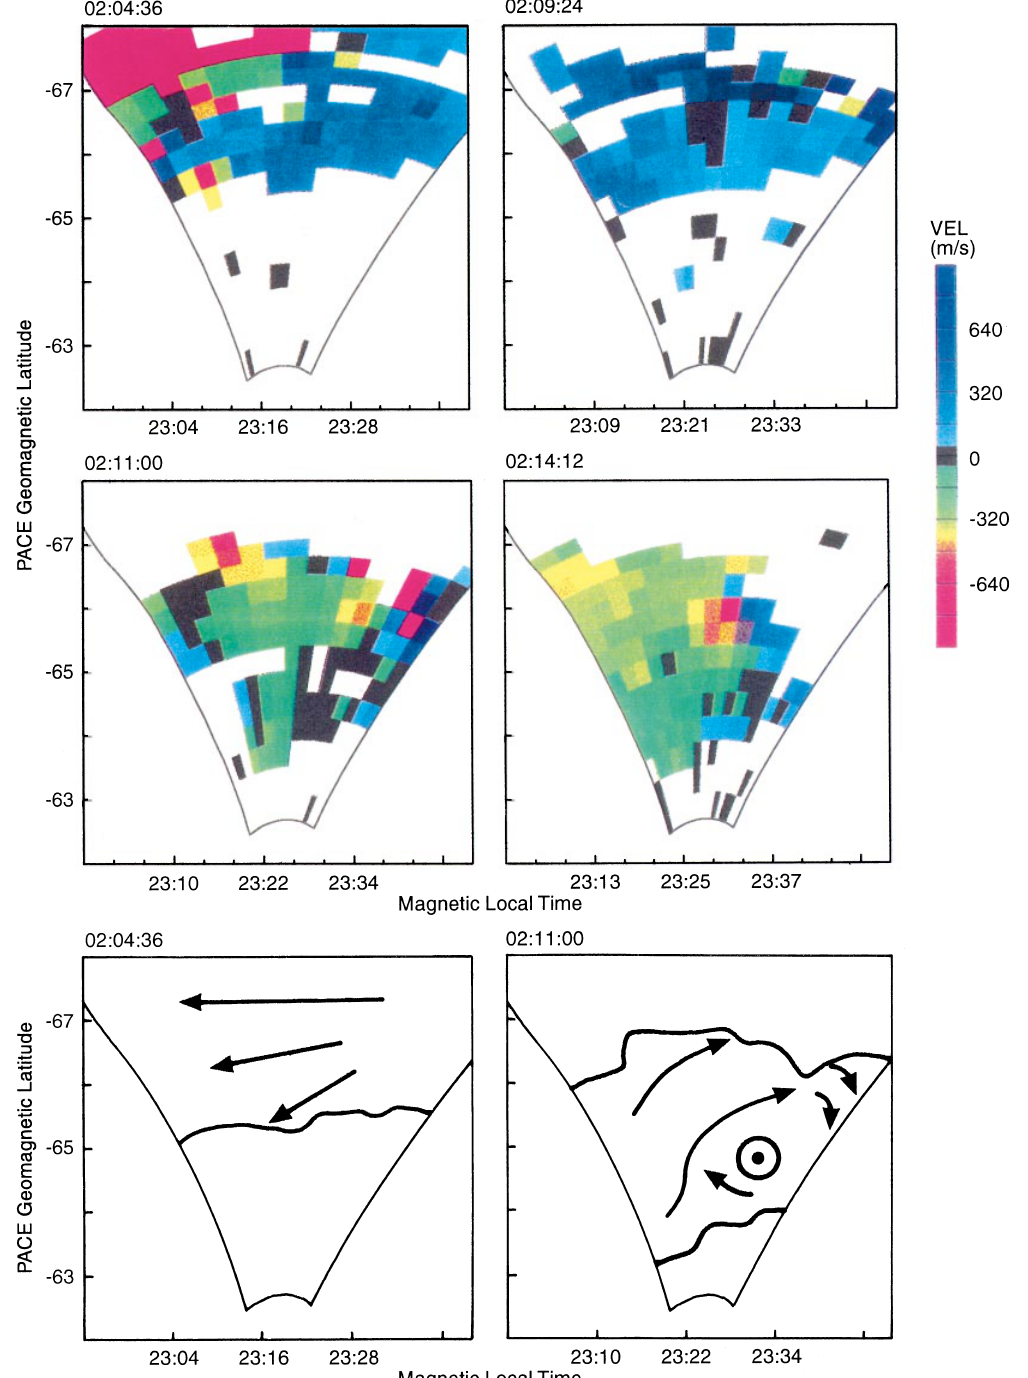
Fig. 5. Colour coded radar maps of the line-of-sight Doppler velocity measured by the Halley HF radar around the time of substorm onset. Positive ( negative ) velocities indicate a flow component towards (away substorm onset, data from the Halley HF radar are shown in Fig. 5. The panel of radar data is divided into four (not all consecutive) radar scans. Each scan displays line-of-sight velocities, colour coded to indicate flow towards (positive velocities) and away from (neg- ative velocities) the radar.